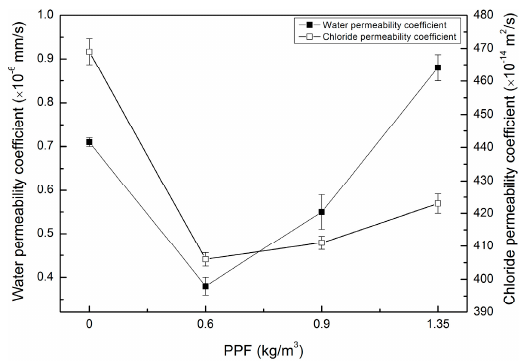
Figure 10. Effect of PPF on permeability of concrete.